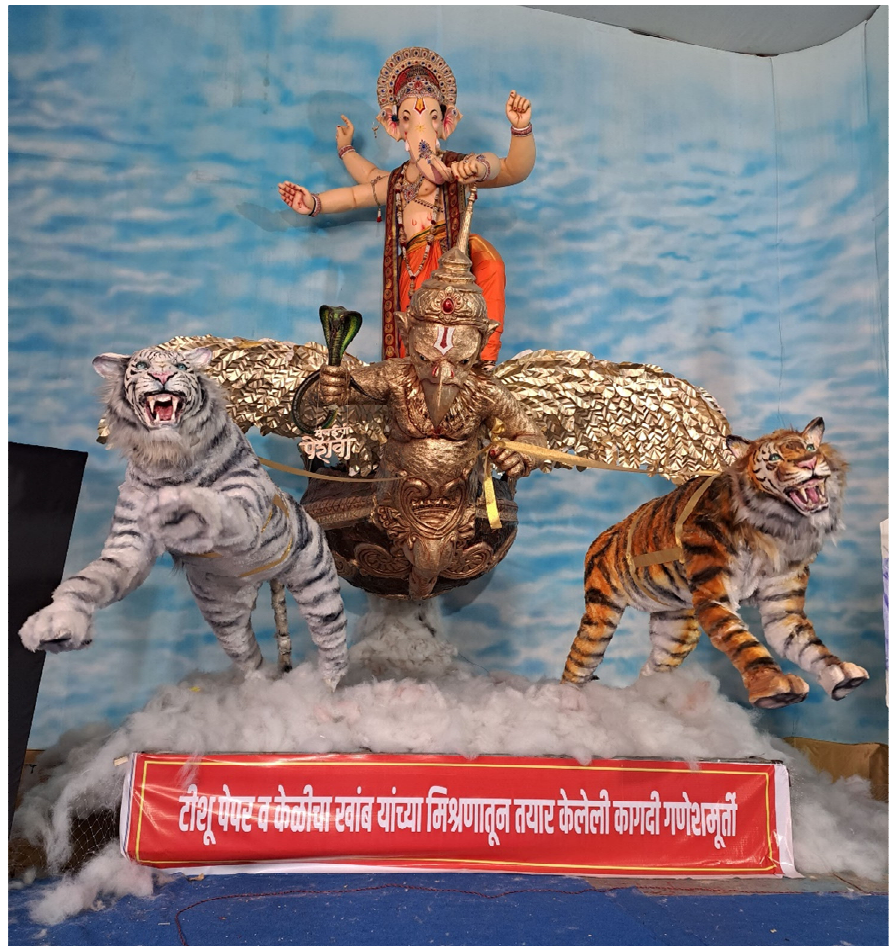
Figure 7. Tissue Ganesha in Vile Parle. Picture taken by author, 9 September 2022, Mumbai. The second Ganesha to be discussed here is referred to as Girgaon cha Maharaja and located in Girgaon (South Mumbai, there are two more of these type of Ganeshas in the area). It is made of shadu chi mati , a type of pottery clay (see Figure 8). On the day of visarjan